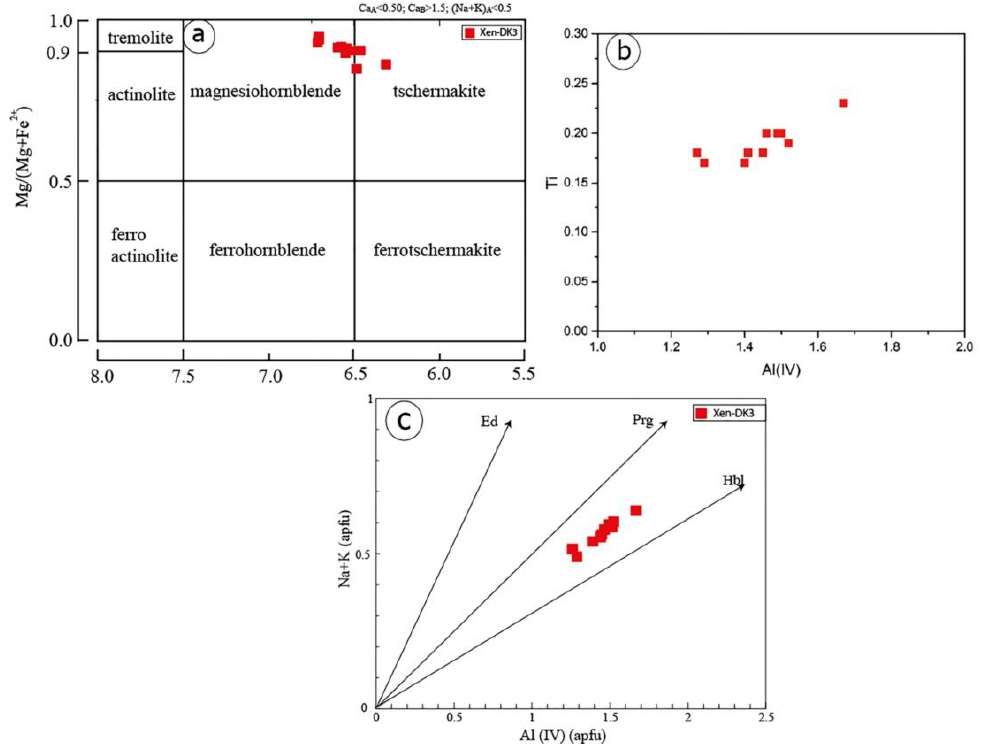
Figure 7. ( a ) Major-element data for amphiboles from diorite enclaves plotted on the Mg/(Mg+Fe 2+ ) vs. Si classification diagram [22]. ( b ) Al (Al IV ) plotted vs. Ti for amphibole from the diorite enclaves [23]. ( c ) Exchange vectors diagram of Edenite – Pargazite and Hornblende based on Al IV amounts vs. (Na+ K) for diorite enclaves [22].